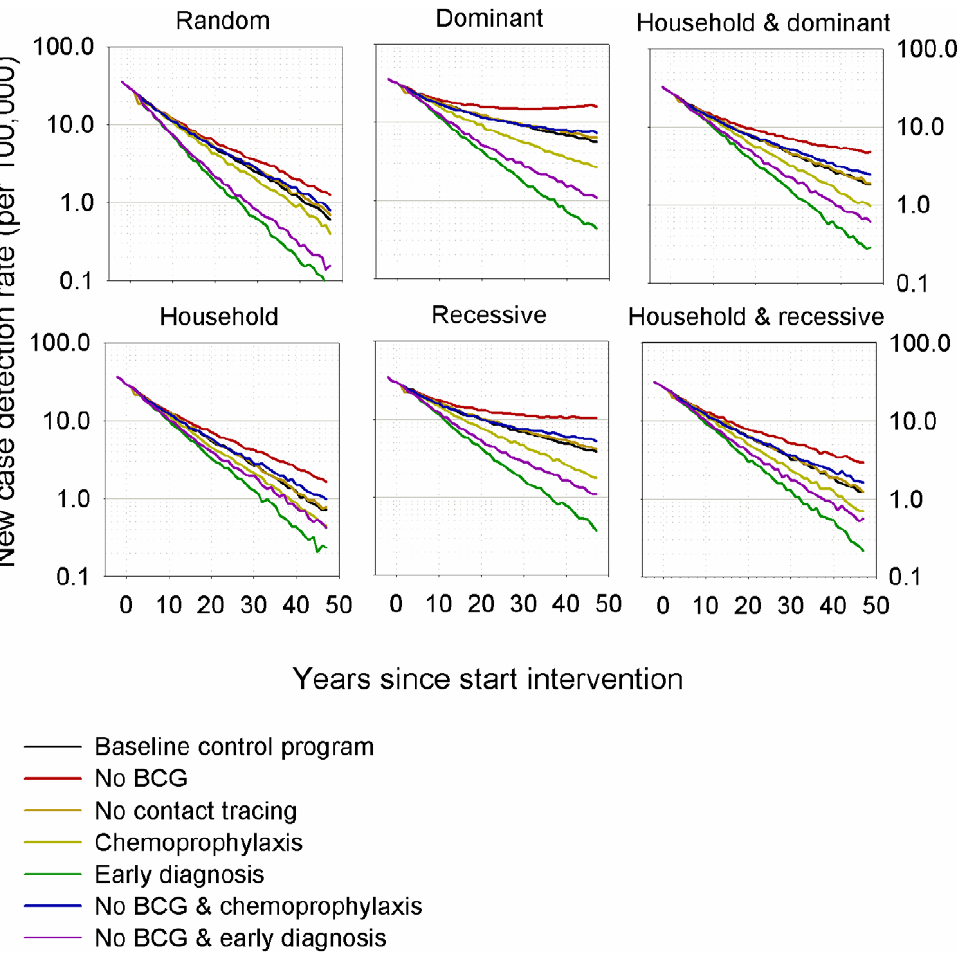
Figure 1. Predicted decline of the new case detection rate with seven intervention scenarios and six mechanisms of leprosy susceptiblity since start of intervention strategy. The baseline program (black line) included passive detection, multidrug therapy, contact tracing, and an infant leprosy-preventative BCG vaccination given at the population level. The other six intervention strategies included the baseline program and, introduction of a new tuberculosis vaccine ineffective against leprosy replacing BCG (red); no tracing of household contacts (orange); a single chemoprophylactic dose of rifampicin that cured 50% of subclinically infected contacts (yellow); early diagnosis of 70% of subclinically infected contacts in each of 3 consecutive annual examinations (green); chemoprophylaxis plus introduction of a tuberculosis vaccine ineffective against leprosy (blue); and detection of subclinically infected contacts plus introduction of a tuberculosis vaccine ineffective against le-pro-sy (purple). Results are the average of 100 runs of the simulation model for each scenario and susceptibilty mechanism.